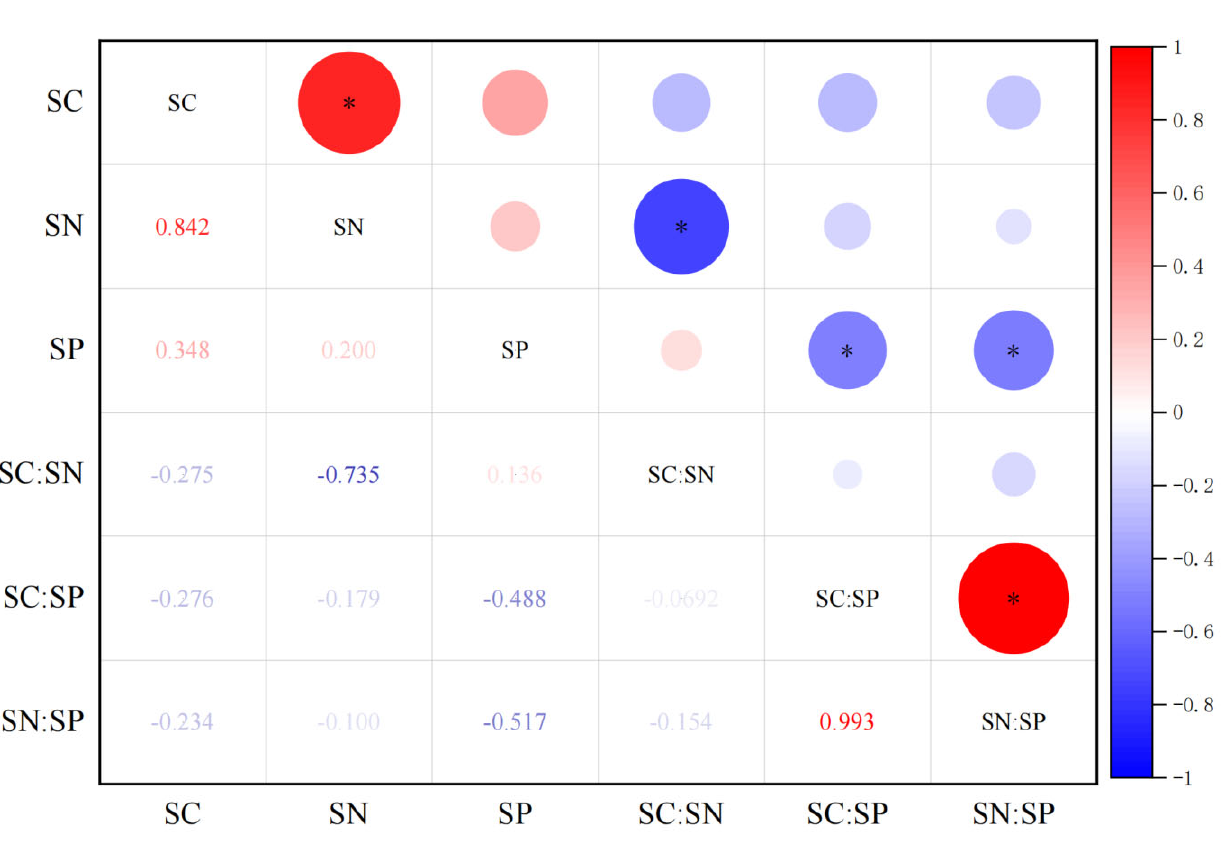
Table 2. Correlations of stoichiometry and stoichiometric ratios between the leaf and soil at different stages of Moso bamboo expansion into Chinese fir forests.